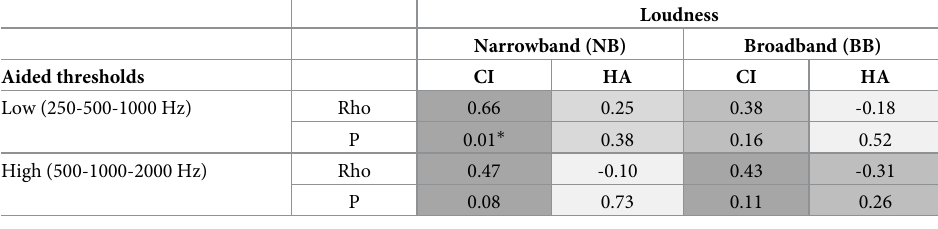
Table 6. Correlations between loudness (AUS for ACALOS NB and AUC for ACALOS BB ) and aided audiometric thresholds within the same modality (CI and